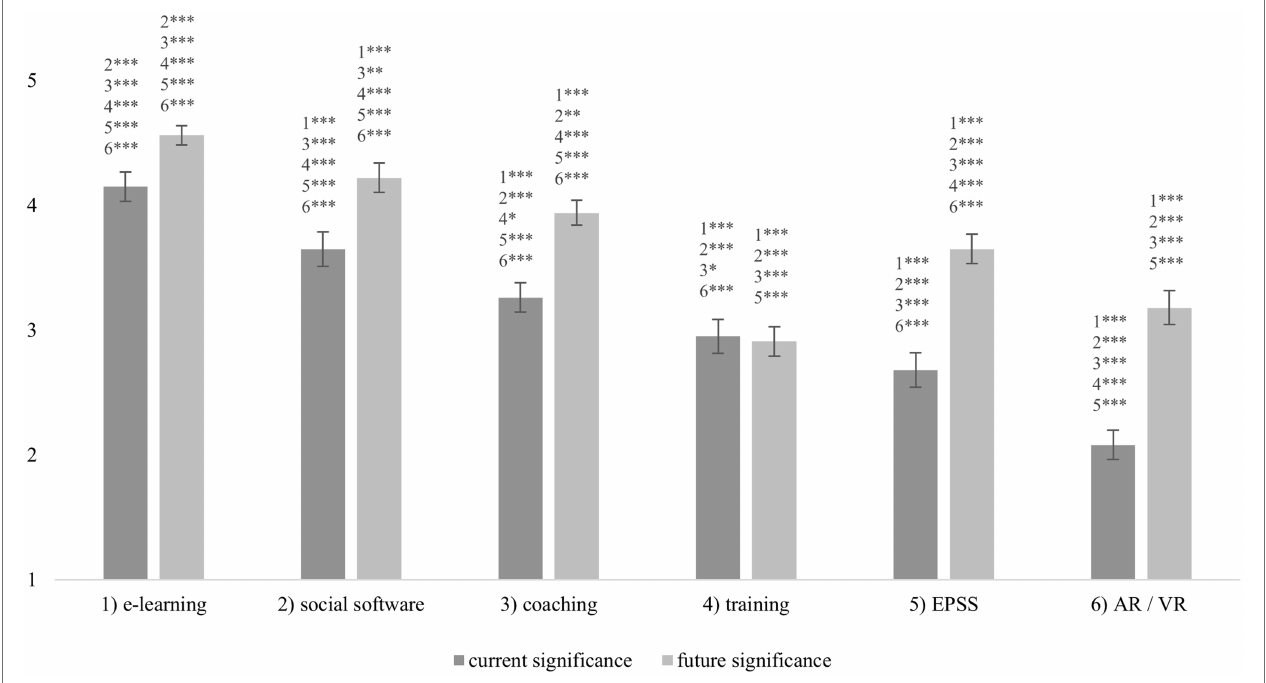
FIGURE 3 | Current and future significance of different learning measures for employees as rated by HR employees. Significant differences, means, and confidence intervals. N = 299. Scale: 1 = irrelevant, 3 = partly relevant, 5 = very relevant. * p < 0.05, ** p < 0.01, *** p <